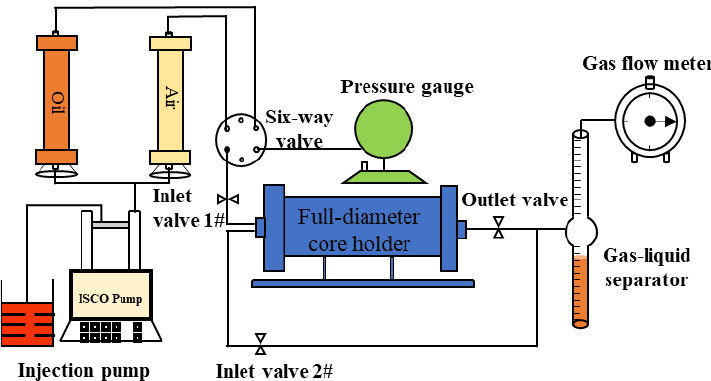
Figure 3. Flow diagram of air flooding/HnP experiments.